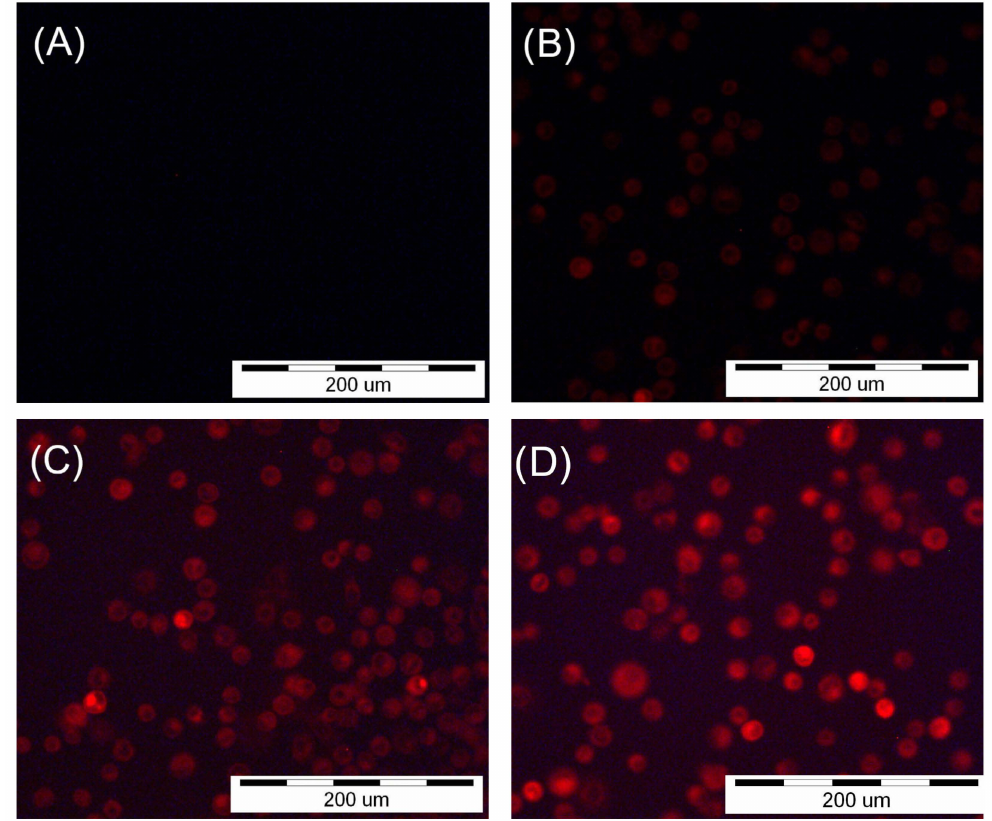
Figure 1. Images of the SCC-25 cells were obtained using an inverted fluorescence microscope after two-hour incubation with HY. ( A ) No fluorescence after incubation with 0 µ M HY solution. ( B ) Fluorescence after incubation with 0.25 µ M HY solution. ( C ) Fluorescence after incubation with 0.5 µ M HY solution. ( D ) Fluorescence after incubation with 1 µ M HY